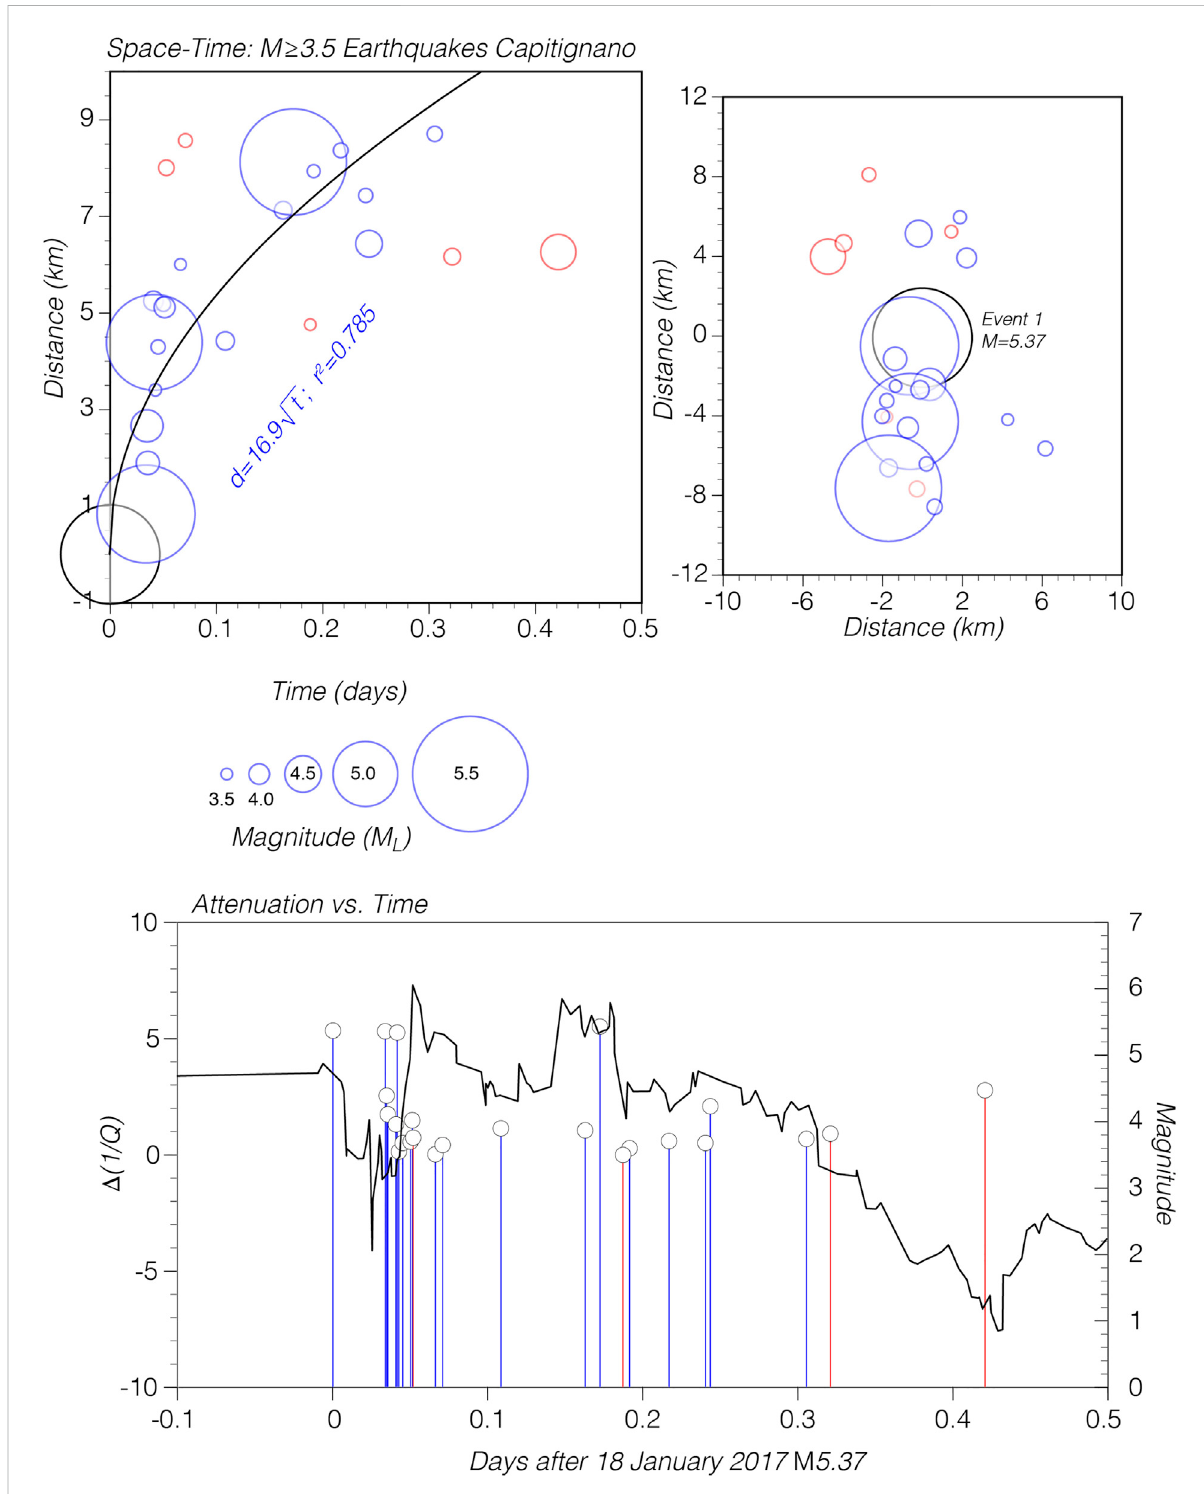
FIGURE 10 Diffusion and attenuation vs. time: Capitignano. Upper :diffusion process associated to theseismic sequence ofCapitignano (18 January2017). Map view to the right. Lower : 2.2 Hz fl uctuation of the seismic attenuation parameter around the pre-Amatrice average. The colors of the vertical lines associated with earthquakes correspond with the earthquakes portrayed by colored circles in the upper